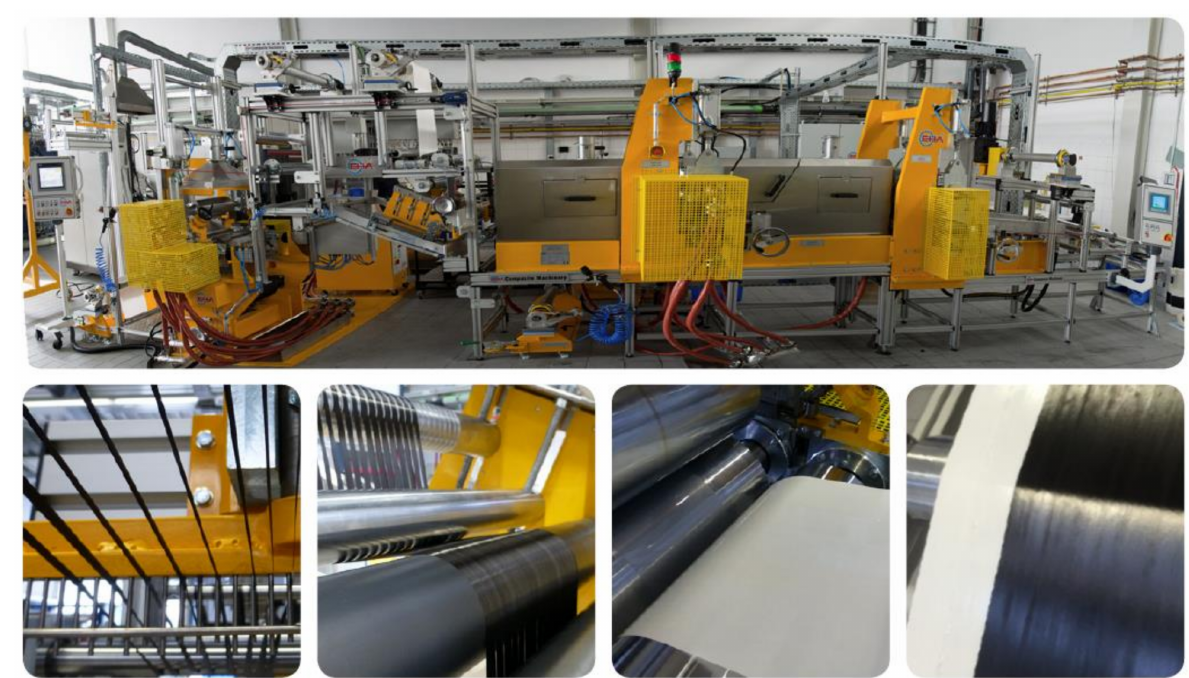
Figure 3. Above: Prepreg machinery at the Department of Polymer Engineering. Below, from left to right: sorting of single UD rovings, fiber pre-spreading unit, resin coating unit, and final produced prepreg,